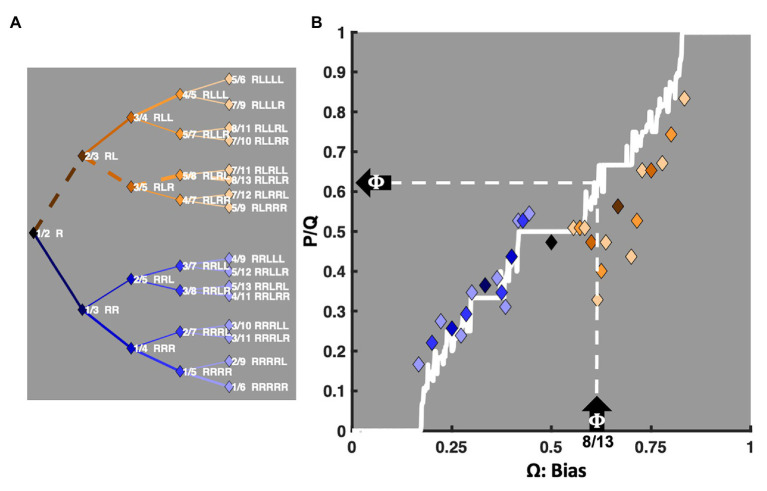
An illustration of the relationship between the Farey tree ratios and the Devil’s staircase. The X-axis of plot (B), labeled Ω, depicts the biasing or driving inputs to the bimanual model. For example, consider the upward pointing arrow on the X-axis indicating 8/13 (0.618), the golden ratio (Φ), as a driving frequency. The left-pointing arrow on the Y-axis then indicates Φ as the likely Farey ratio (p/q) at which two suitably coupled oscillators, such as those entailed by the bimanual model, will display mode-locking. The corresponding mediant ratios are indicated on the left, in plot (A). All 31 trial-history permutations are formatted sideways as a Farey tree, and approximate their respective locations on plot (B)’s Y-axis. The solid white line bisecting plot (B) is the Devil’s staircase. Each plateau in the staircase indicates the width of a corresponding Arnold tongue, an attractor basin in which a range of biasing frequencies will likely yield a single mode-locking ratio. The various plateau widths result from the fact that ratios with smaller denominators are more stable than ratios with larger denominators. Notably, the staircase was generated with A = 0.85, and K = 0.95, and driven from Ω = 0 to Ω = 1 in increments of 0.001. For simplicity, the noted A and K parameters were fixed for this and all subsequent plots and statistical contrasts in this article. The mean response times for Remington’s (1969) data set, taken from a table of condition means appearing on Luce (1986, p. 288), were normalized to the unit interval, and plotted against the staircase. Each diamond marker indicates a specific trial-history in terms of the color of its corresponding Farey tree branch on plot (B). The correlation between the normalized response times and their predicted Farey ratios, encoded by the Devil’s staircase is r(29) = 0.89, p < 0.0001. Notable exceptions are the ratios on the golden ratio path. They are related to antiphase bimanual coordination and discussed in The Transition From Repetition to Alternation Dominance section.